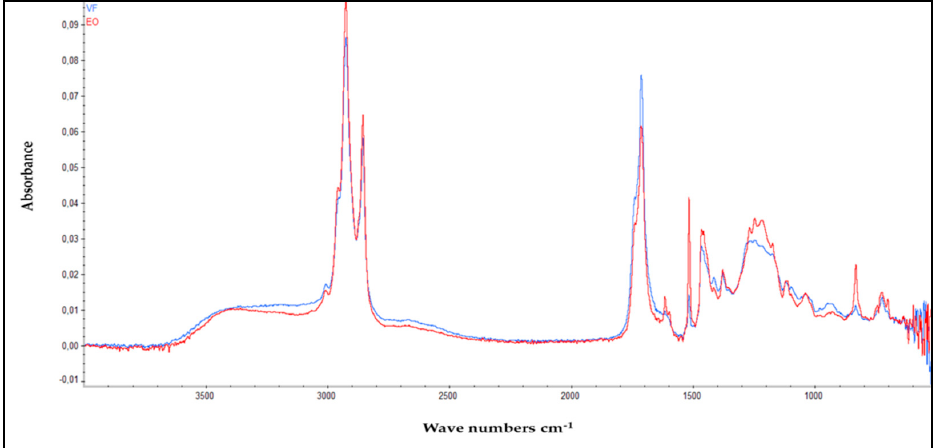
Figure 1. ATR—FTIR spectra of the VF (Blue) and EO (Red) extracted from OMW.